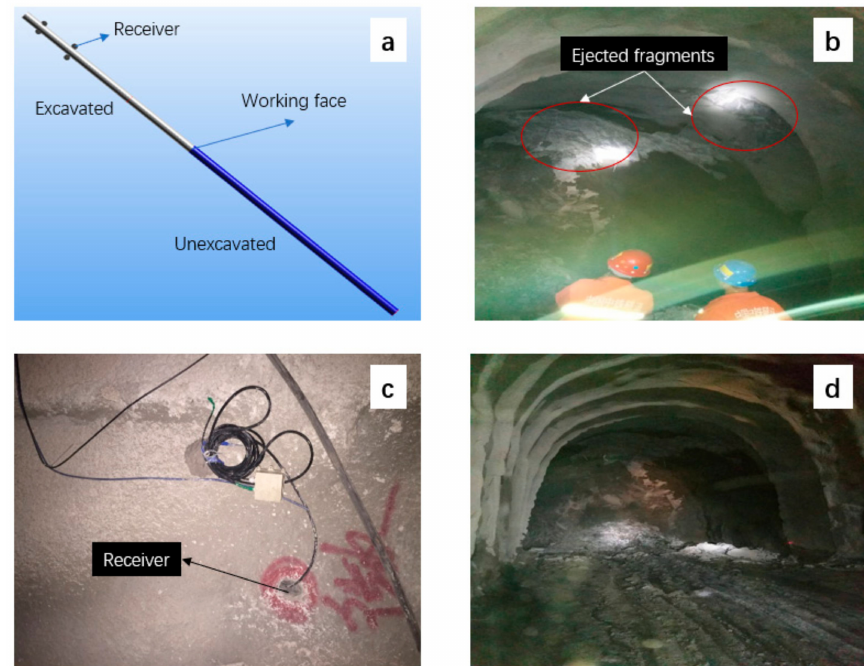
Figure 9. Tunnel engineering conditions: ( a ) receiver layout and progress of tunnel excavation, ( b ) ejected fragments on the top of the working face, ( c ) receiver position indicated by red paint, and ( d ) working face of the project.